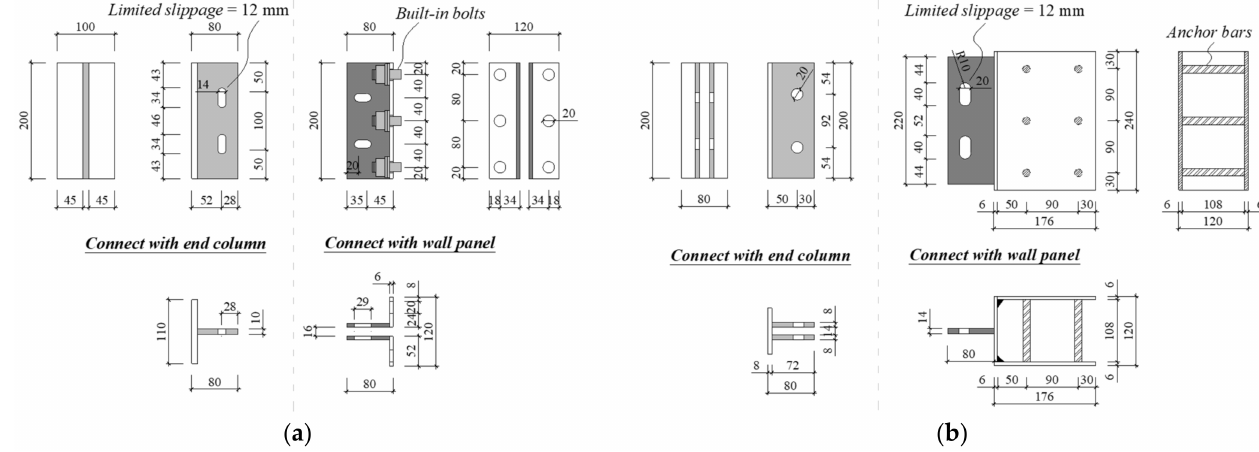
Figure 7. Details of horizontal connection in PC walls (unit: mm). ( a ) W1-R; ( b ) W2-R.